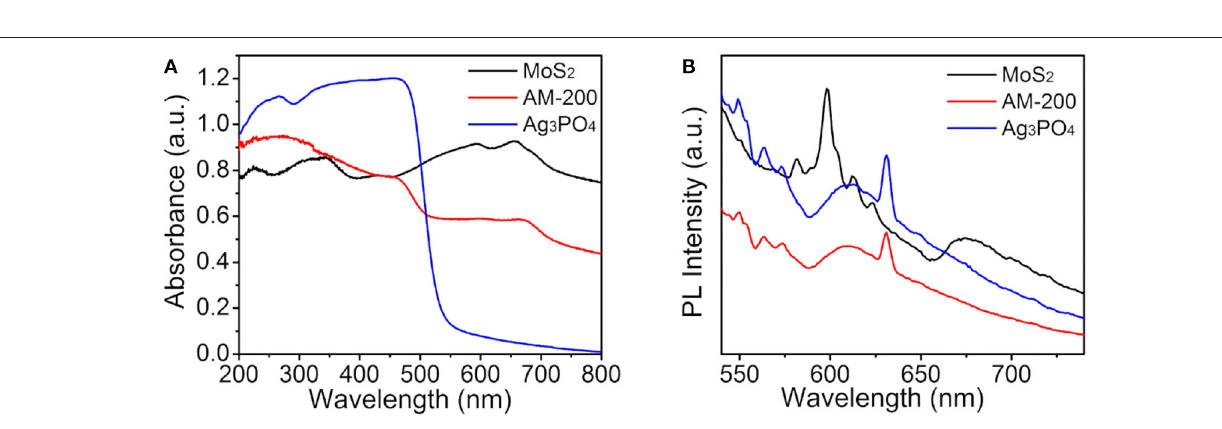
Frontiers in Chemistry | www.frontiersin.org